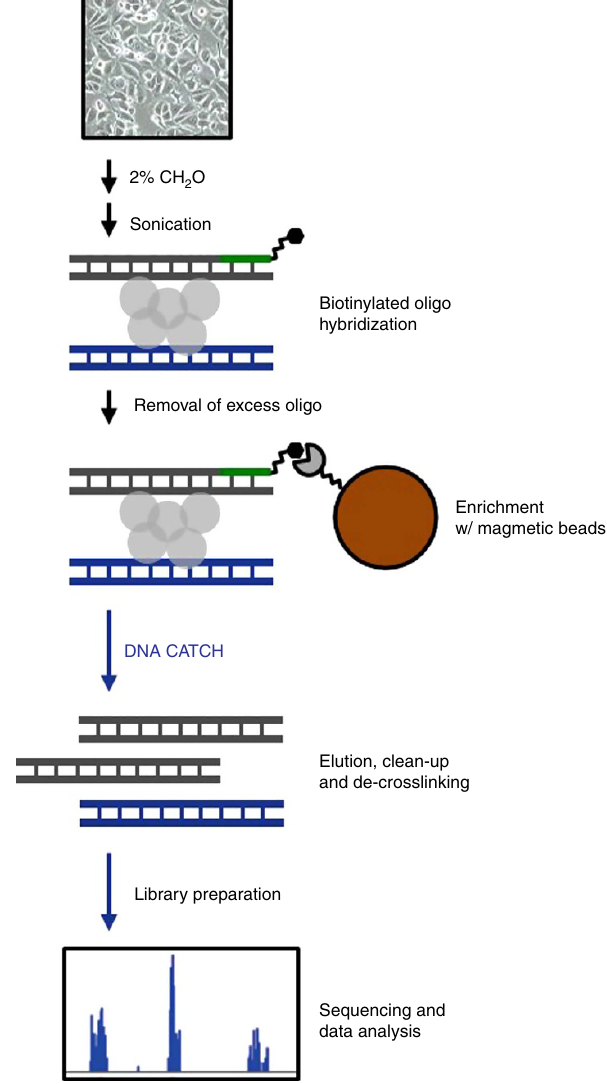
Figure 1 | The process of CATCH. The flowchart demonstrates philosophical basis of CATCH. It shows that a cell population is first formaldehyde-fixed to capture DNA–protein–DNA interaction. The DNA is then sheared into small fragments using sonication. The resulting fragmented DNA–protein–DNA complexes are hybridized to a biotinylated oligo in order to enrich for a region of interest. While the targeted sequence is pulled out of the entire DNA population using streptavidin-linked magnetic beads, any associated protein–DNA complexes are also enriched. Subsequent de-crosslinking and PCR amplify the target sequence and any (potentially) associated sequences. Next-generation sequencing allows the identification of any DNA sequences physically associated with the locus (via proteins) to which the biotinylated probe was originally